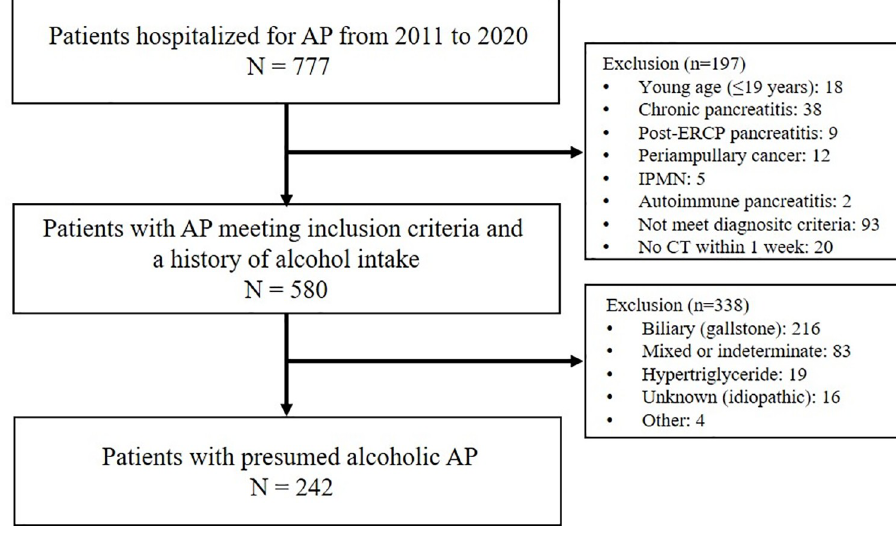
Fig 2. Flow-chart of patient selection. AP, acute pancreatitis; ERCP, endoscopic retrograde cholangiopancreatography; IPMN, intraductal papillary mucinous neoplasm; CT, computed tomography.